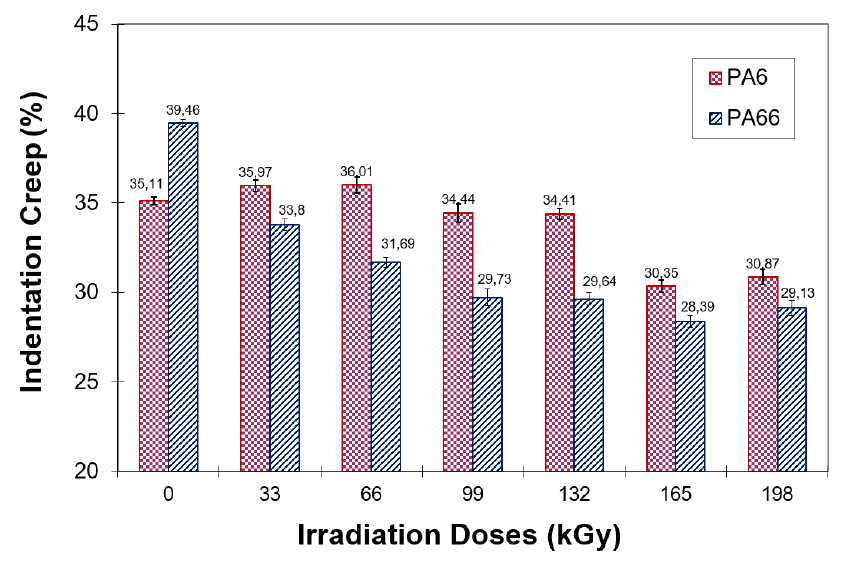
Figure 3. Indentation creep.